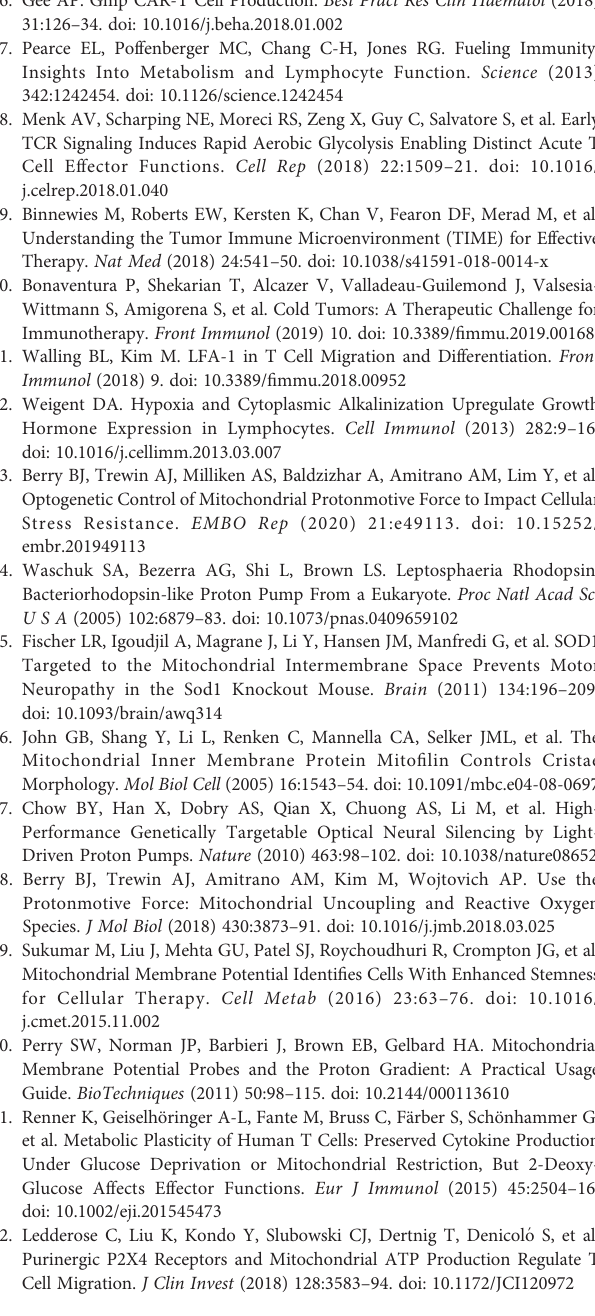
Supplementary Figure 4 | OptoMito-On is expressed in mitochondria. CD8 + T cells, HEK293T cells, and HeLa cells expressing OptoMito-On were stained with MitoTracker Red and images were taken on an inverted microscope. Then the Pearson ’ s correlation coef fi cient was calculated in ImageJ software for the entire cell body of each cell. Data shown as mean ± SEM. Supplementary Figure 5 | OptoMito-On does not impact glycolysis. (A) ATP assay with OptoMito-On OT-I T cells treated with or without 10 mM 2-DG. Same light activation setup as Figure 4C . Data shown as mean ± SEM (n = 3-4). (B) SortedOT-ITcellsexpressingeitherOptoMito-OnorGFPwereplatedinLeibovitz ’ s